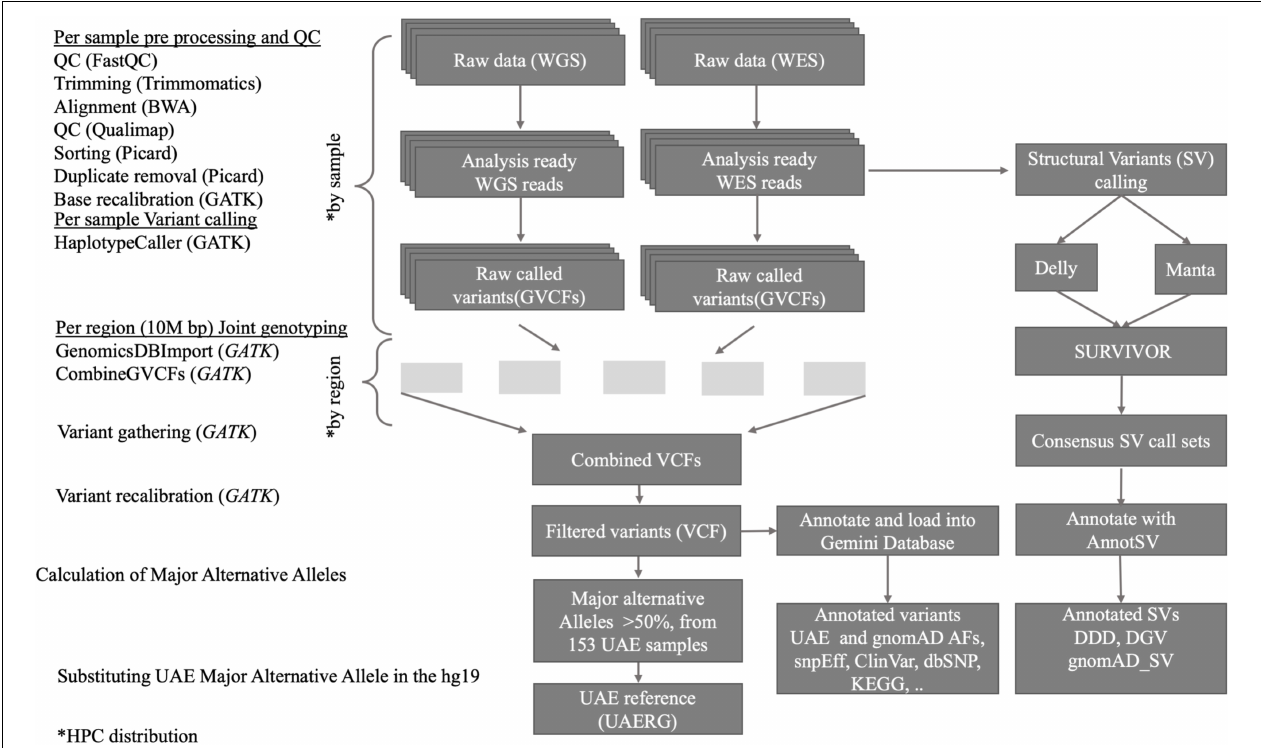
FIGURE 1 | Overview of the data processing workflow, resources, and tools used for the joint short and structural variant calling and reference genome construction from the 153 UAE